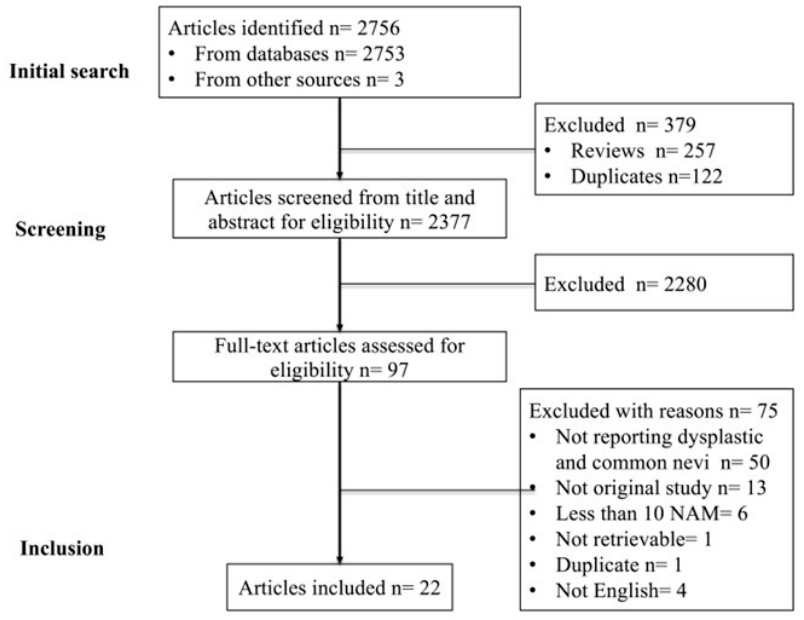
Figure 1. PRISMA flow diagram of studies identified, screened, and included in the meta-analysis.